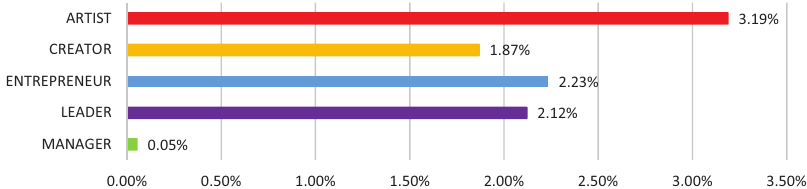
Figure 1. Means of the 50 features of each investigated identity perceived by artists in comparison to non-artists (source: created by